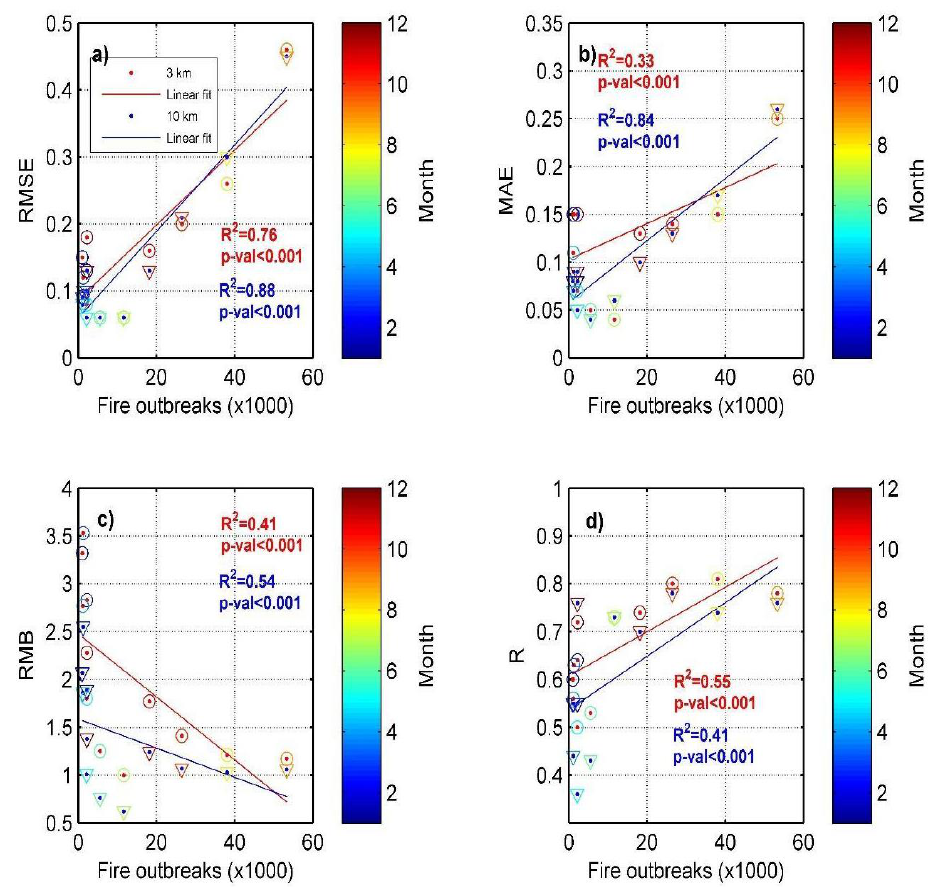
Figure 7. The plots show the linear regression between the mean values of fire outbreaks and the monthly statistical parameters (characteristic year) of the regressions between AERONET and MODIS DT. ( a ) RMSE — Root Mean Square Error, ( b ) MAE — mean absolute error, ( c ) RMB — relative mean bias, and ( d ) R — the correlation coefficient. The color outlines inform the month of each regression point.